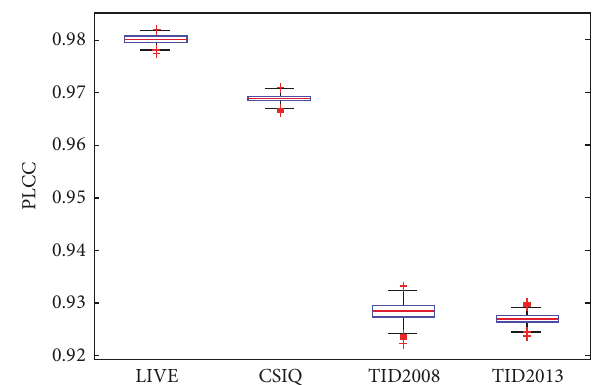
Figure 6: Box-plots of cross-validation phase.